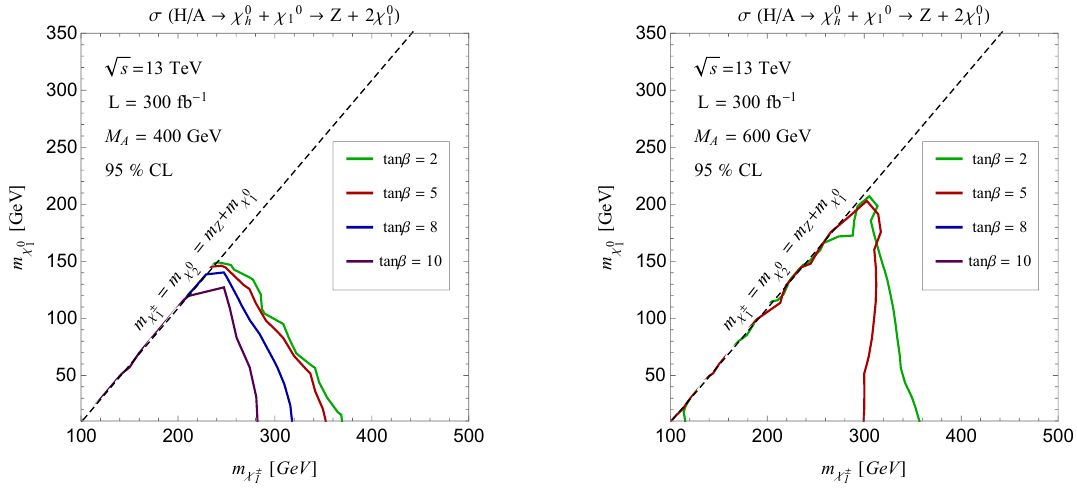
Figure 6 . 95 % CL bounds on the heavy neutral Higgs decay into electroweakinos H=A Z + 2 (cid:31) 0 , with Z ‘ + ‘ (cid:0) . With integrated luminosity of 300 fb (cid:0) 1 and m 1 !